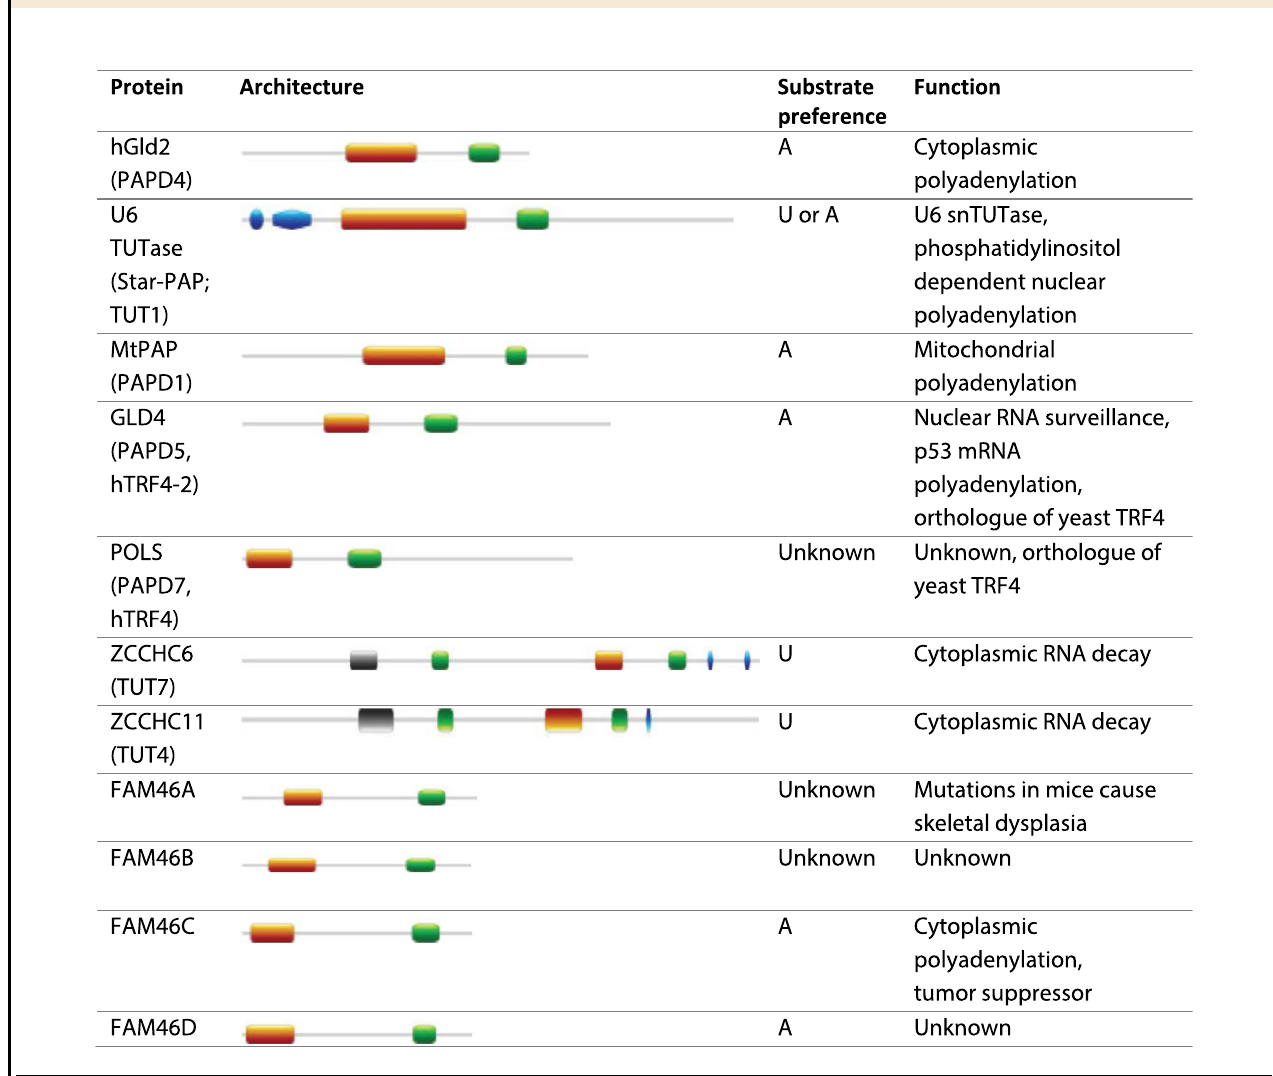
Table 1 List of human non-canonical PAPs and